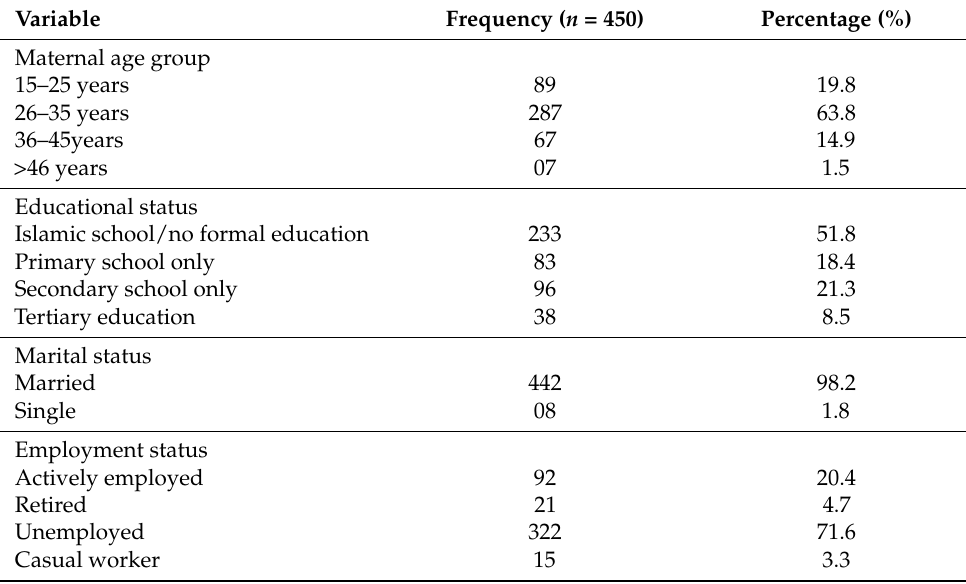
Table 2. Sociodemographic characteristics of the mothers of the preschool